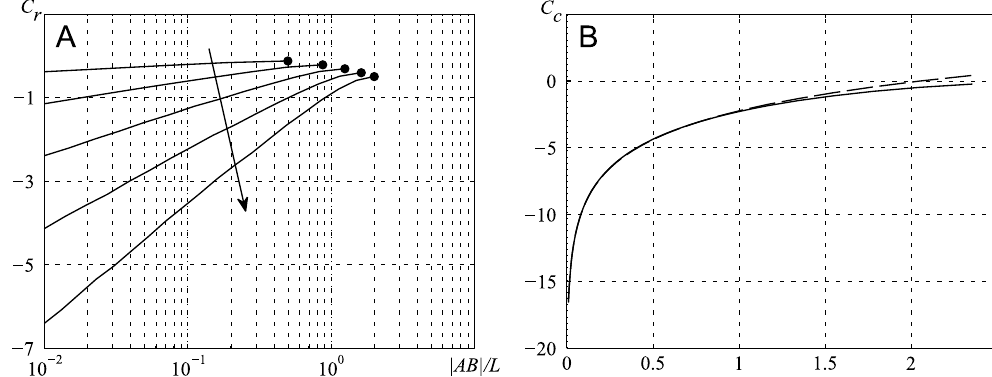
Figure 7. Dependence of constants C r and C c on size of pump openings |AB|/L and |AB|/2 R, respectively. ( A ) Rectangular chamber, dependence of C r on |AB|/L for different W/L. The arrow indicates direction of increase of the W/L ratio, with uniform steps of 0.5, starting from 0.5 and ending at 2. Circles at the end of each curve correspond to limiting cases of pumps with W = AB. ( B ) Circular chamber, with dependence of C c on θ = |AB|/(2 R); it tends to zero as θ → π . Dashed line is an empirical approximation of this dependence as C c = 3.1 ln θ −